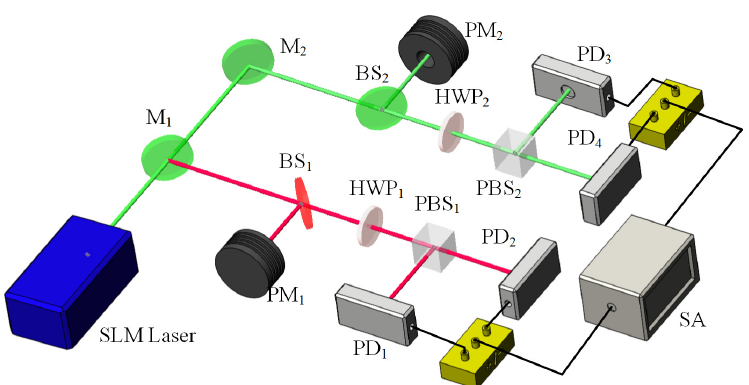
Figure 18. Experimental setup of the noise manipulation [31]. Reprinted with permission from [31] c (cid:13) The Optical